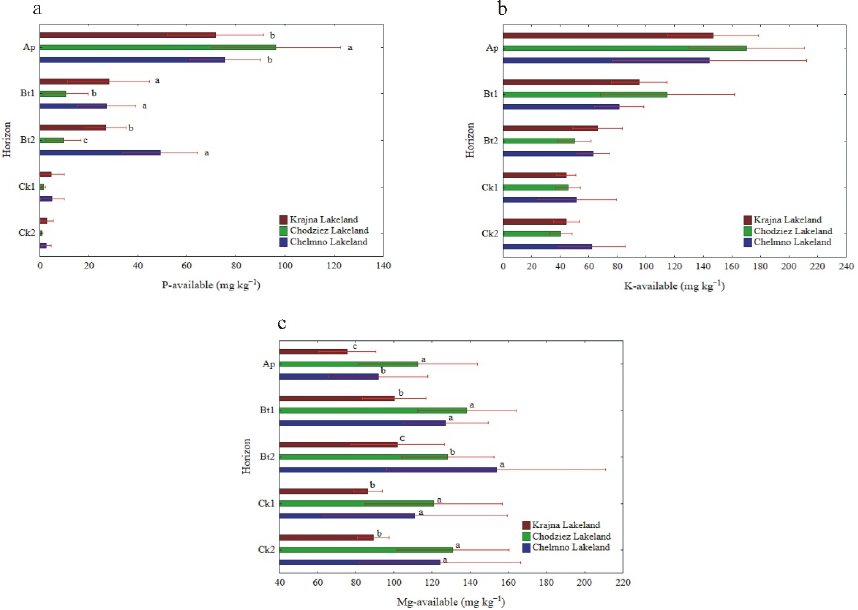
Figure 2. The content of available P ( a ), K ( b ) and Mg ( c ) at different soil depths (mean and SD). Different lowercase letters indicate significant differences ( p < 0.05) between study sites (within the same genetic horizons of the profile).